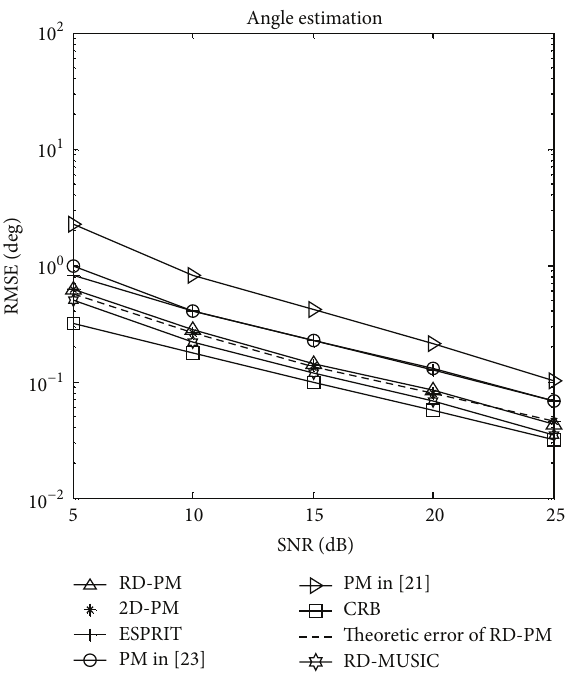
Figure 5: Angle estimation performance comparison ( 𝑀 = 8 , 𝑁 = 8 , 𝐽 = 100 , and 𝐾 = 3 ).